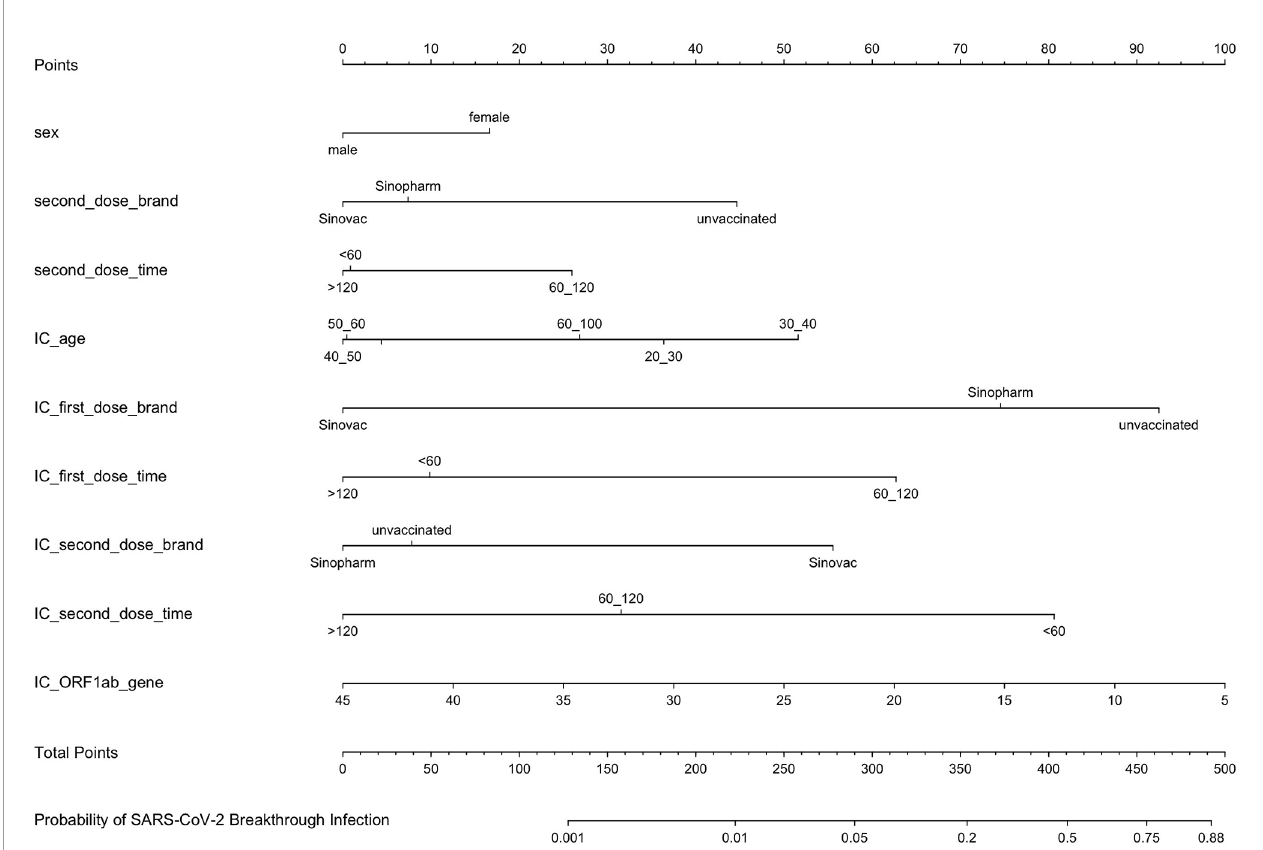
FIGURE 2 | A predictive nomogram model for SARS-CoV-2 breakthrough infection established by independently associated risk factors from multivariate logistic regression. IC, index case of vaccinated